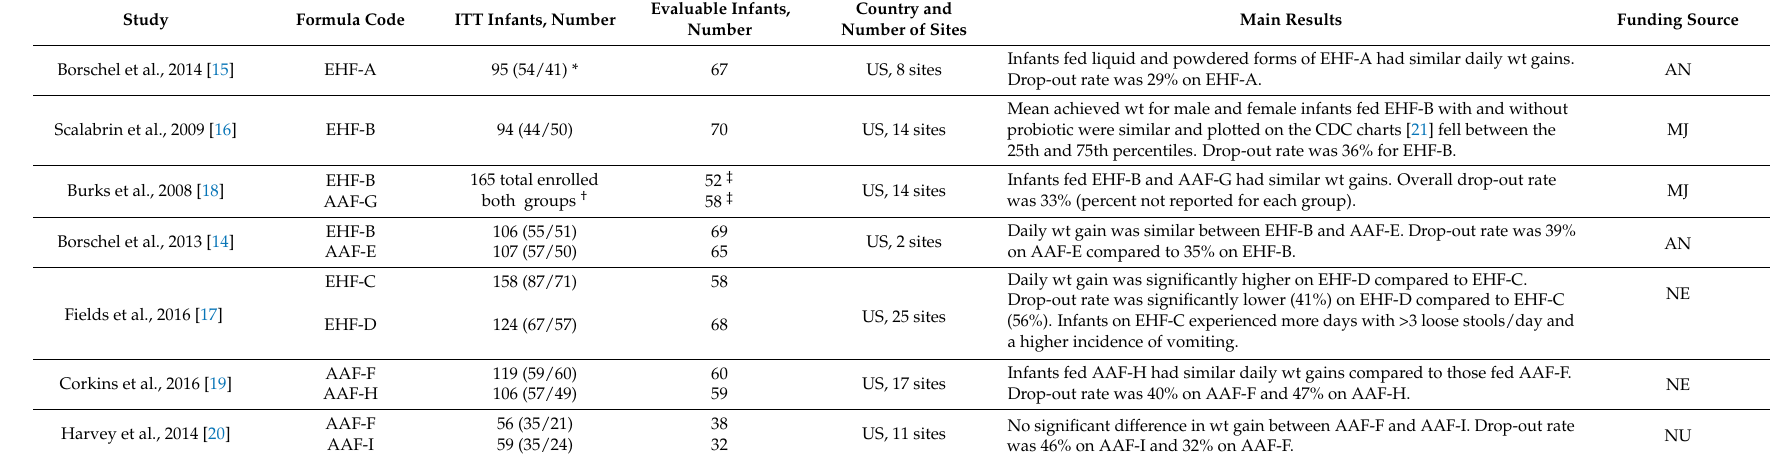
Table 3. Summary of extensively hydrolyzed formula and amino acid-based formula growth studies included in the narrative